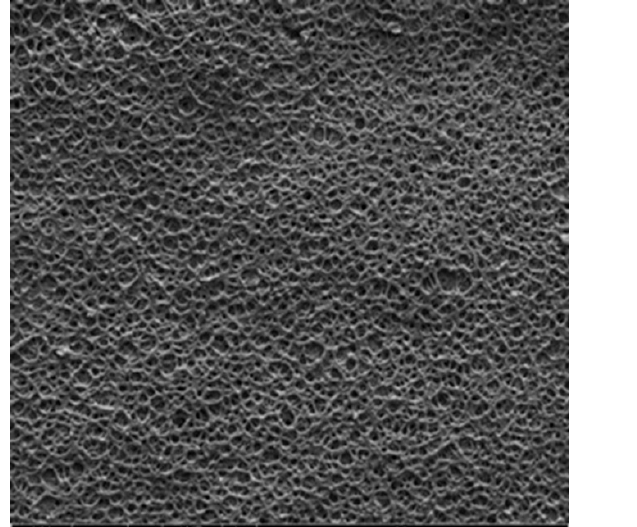
Figure 8. Sulfuric acid group (SA30). Surface etching with 98% sulfuric acid for 30 s promoted an increased surface degradation, where it is no longer possible to observe the milling grooves and the pores are larger and deeper. Magnification: 5000× and 10,000×.